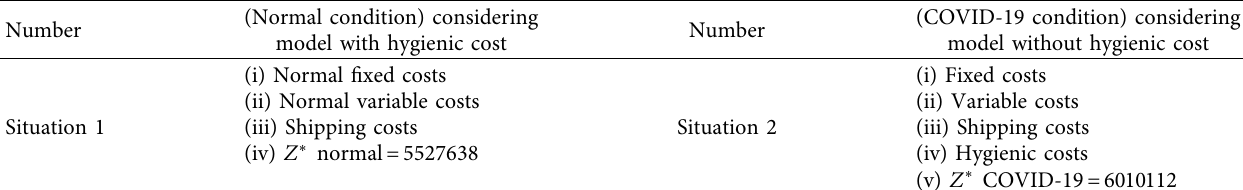
Table 4: The optimization value of the economics OF with different scenarios.